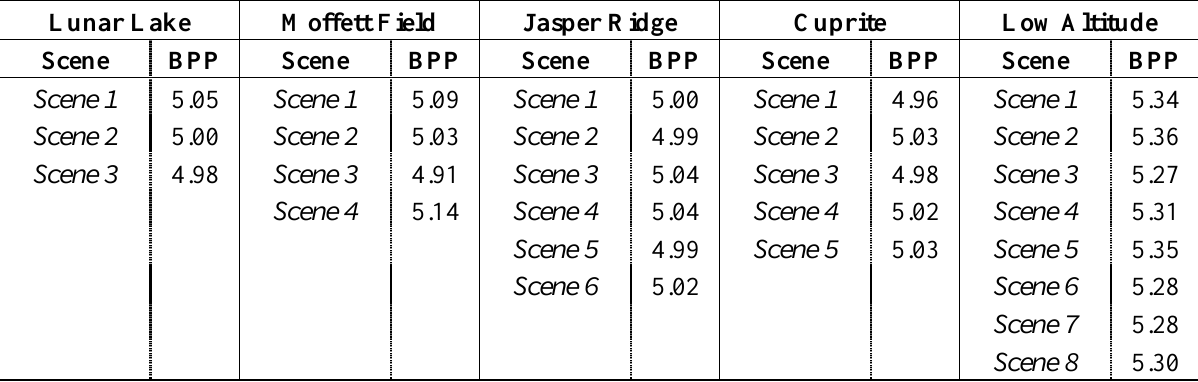
Table 4. Results (BPP achieved for each scene of the hyperspectral imagery without band ordering).